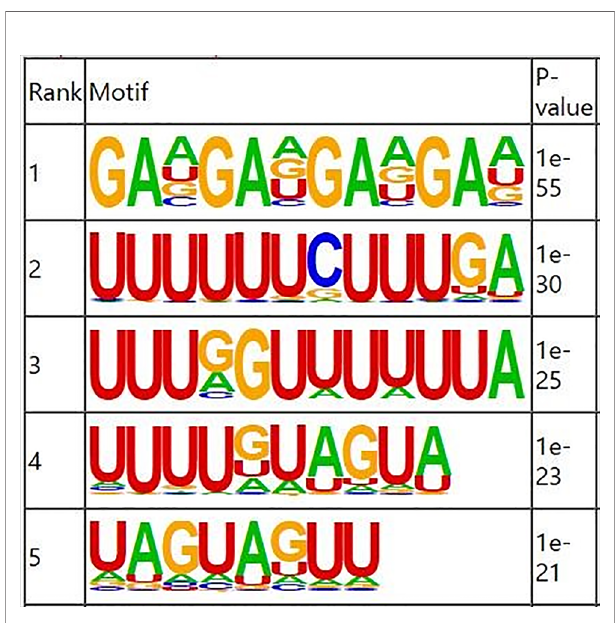
FIGURE 3 | Sequence logo showing the top motifs enriched across differential m6A peaks identi fi ed from skin samples.